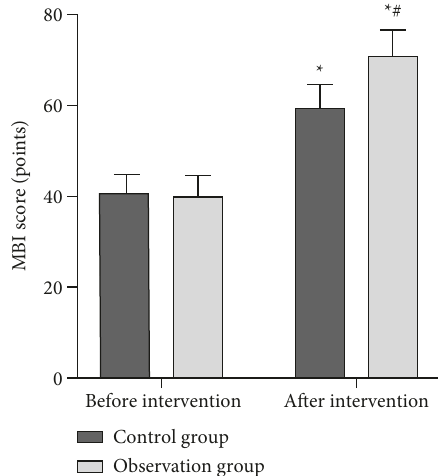
Figure 2: Comparison of cognitive function between two groups. Compared with before intervention,